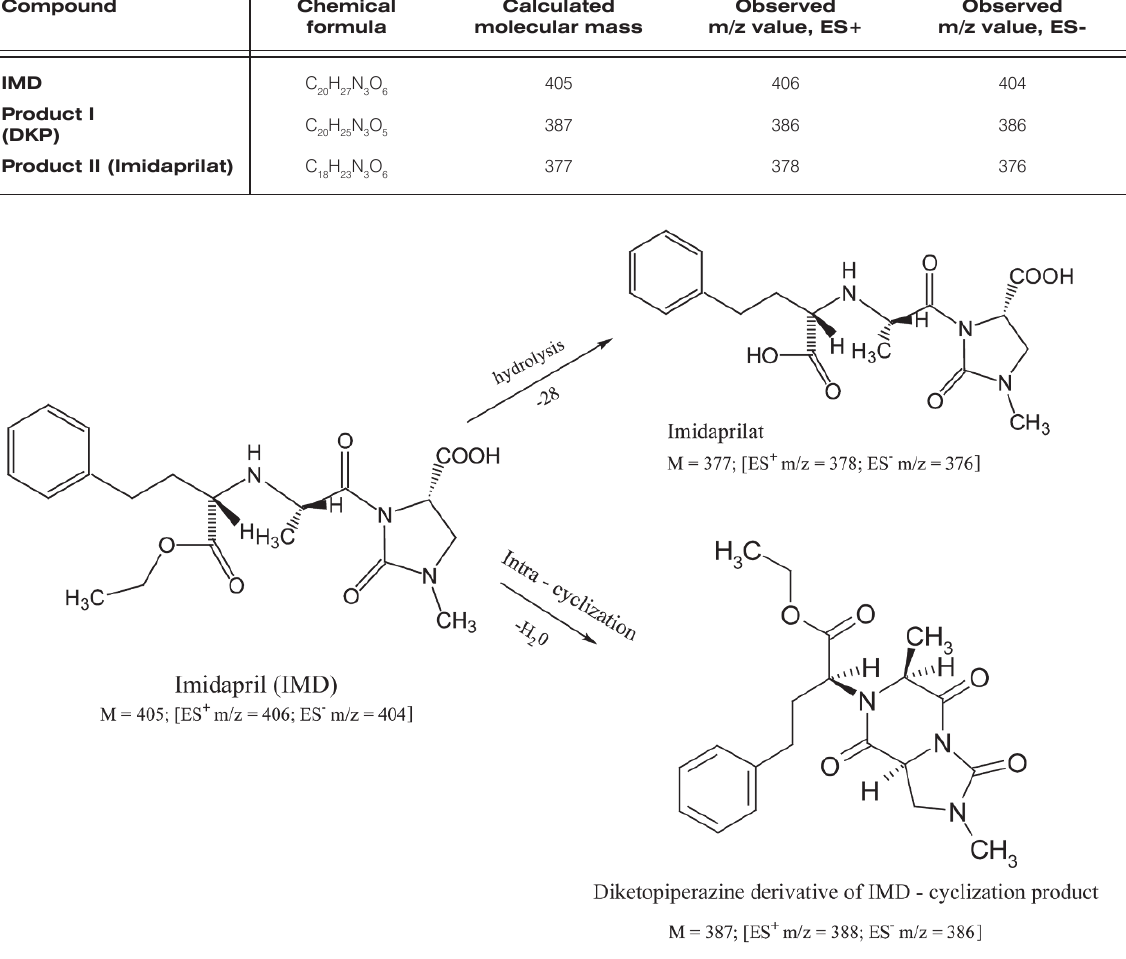
Table 4. The m/z values of [M+H] + and [M-H] - for IMD and its degradation impurities in solid state. Compound